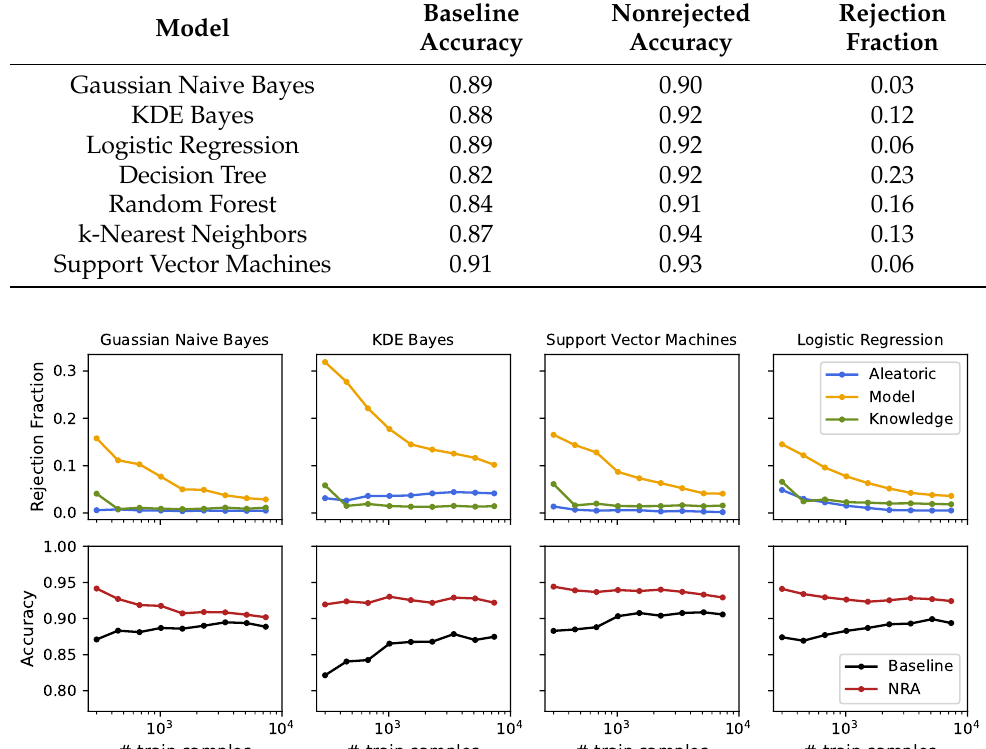
Table 3. Performance measures for different models using a training size of 7352 samples and the Human Activity Recognition (HAR) dataset.